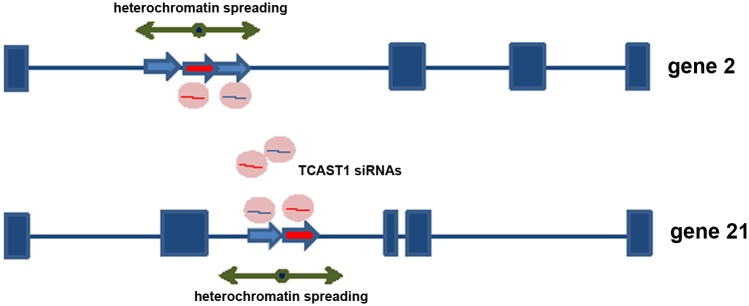
Model for satellite DNA- mediated suppression of genes.Transcripts of TCAST1 satellite DNA, specifically induced after heat stress, are processed into siRNA which target via sequence identity dispersed TCAST1 elements associated with genes. By guiding chromatin modifiers TCAST1 siRNAs increase the level of silent heterochromatin marks at dispersed TCAST1 elements and proximal regions. Temporary assembly and spreading of heterochromatin suppresses activity of nearby genes. Genes associated with elements 2 and 21 are schematically shown: exons are represented by rectangles, elements TCAST1 by arrows and complex containing TCAST1 siRNAs by a circle.